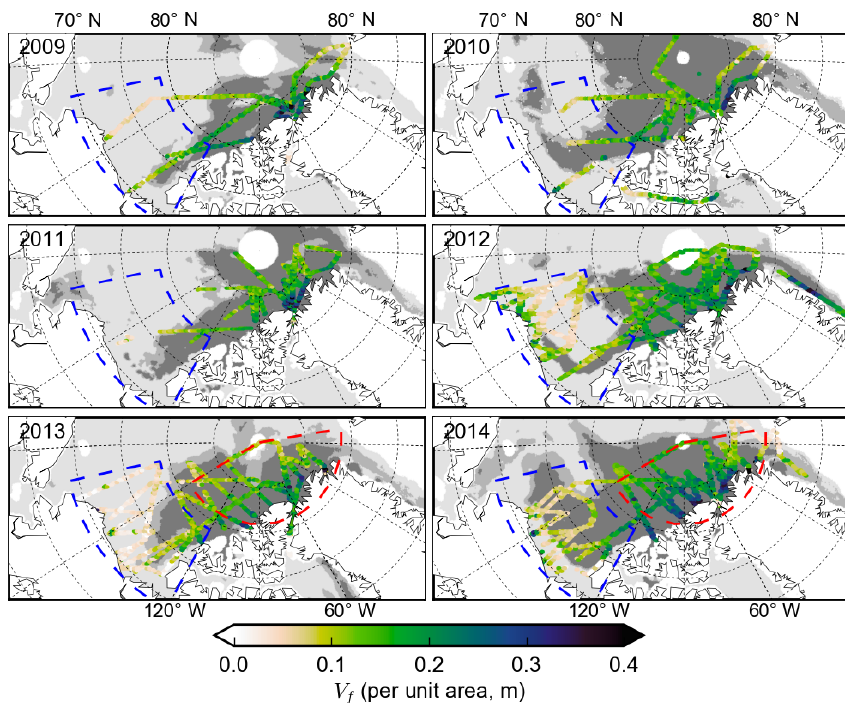
Figure 8. As in Fig. 5 but for the surface feature volume (per unit area), V f . Table 3. Surface feature height statistics, as in Table 2 but for the processing using an 80cm threshold, with the results using all features in each region shown (not delineated by ice type). Central Arctic